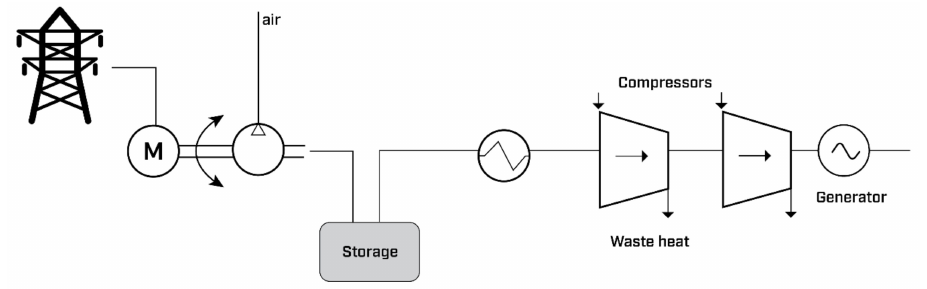
Figure 6. Compressed air energy